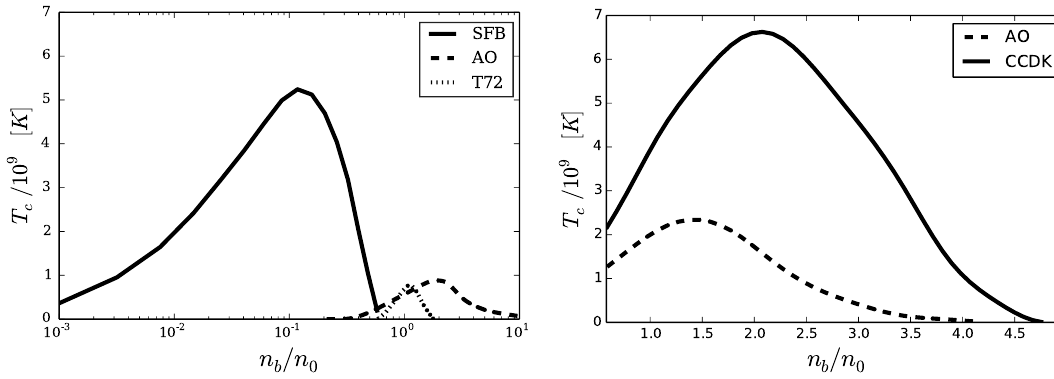
Figure 3. Density dependence of the critical temperature for the considered singlet and triplet neutron gaps (left panel) and proton singlet pairing gaps (right